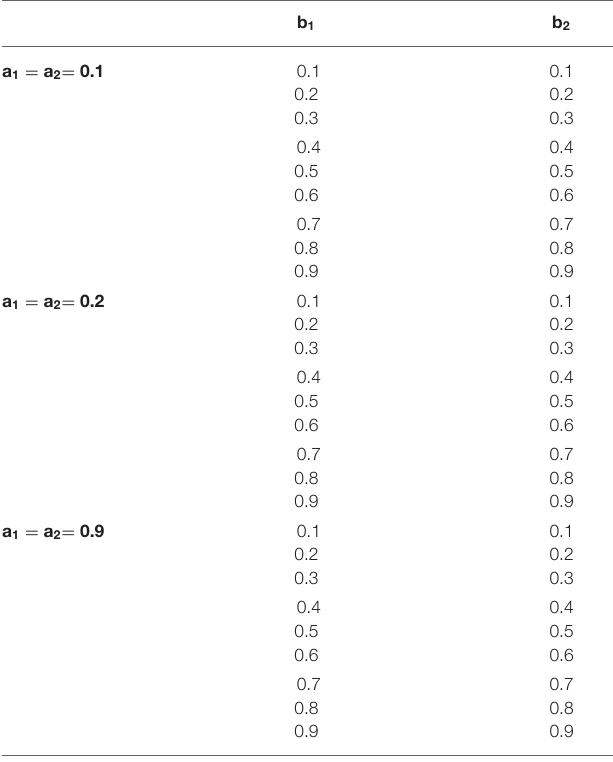
TABLE 5 | Parameter values in four simulation scenarios. b 1 b